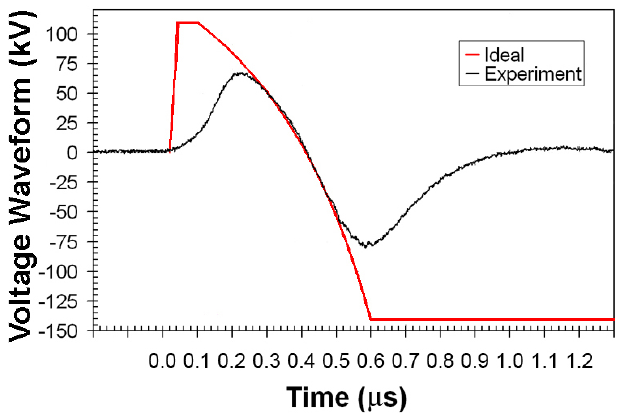
FIG. 3. (Color) Comparison between the experimental voltage waveform (black) used in the induction module in order to apply (cid:4) r; z (cid:5) in the (cid:4) t (cid:5) in the acceleration gap and the ideal voltage waveform the E tilt z z (red) which would impose an ideal linear velocity tilt on the (cid:4) r (cid:8) drifting beam (from 0 : 1 to 0 : 6 (cid:1) s ). The experimental voltage z waveform is used for the temporal dependence of the axial (cid:4) t (cid:5) , in the fluid electric field, E tilt z